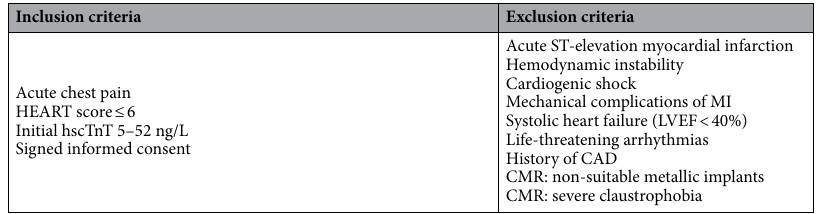
Table 1. Inclusion and exclusion criteria of the study 30 . hscTNT high-sensitive cardiac troponin T, LVEF left